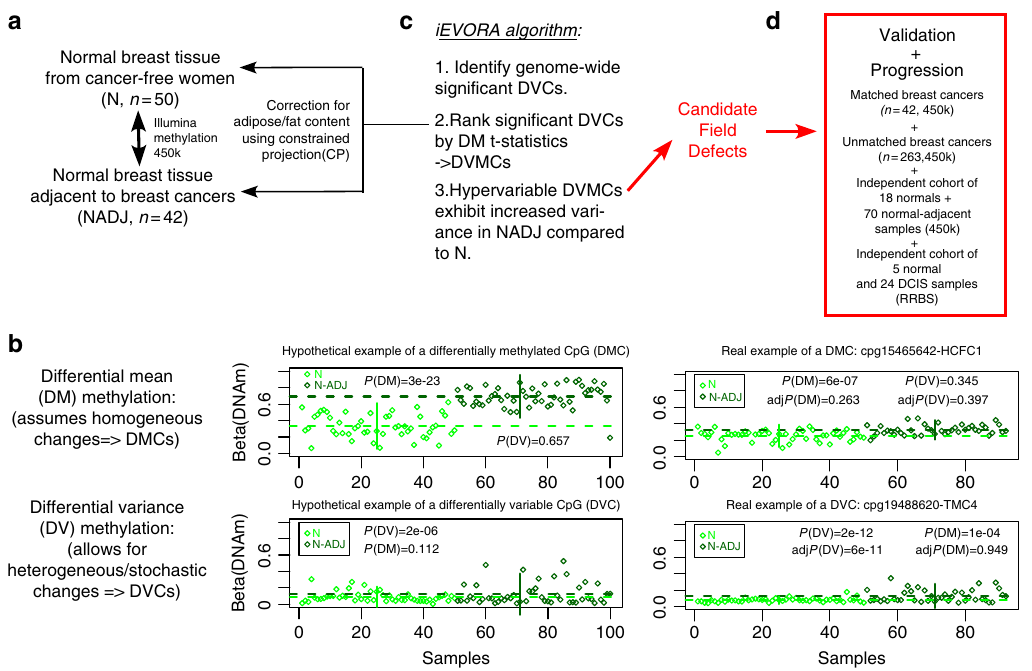
Figure 1 | Overall analytic strategy for identifying and validating field defects in breast cancer. ( a ) Aim is to identify DNA methylation changes between normal tissue from cancer-free women (N) and age-matched normal samples adjacent to breast cancers (NADJ). This is done correcting for variable adipose/ fat content across breast tissue samples and then performing a supervised analysis. ( b ) Two feature selection paradigms are possible: (i) a standard paradigm by which we select differentially methylated CpGs (DMCs) and which assumes homogeneity within the phenotypes being compared, (ii) a novel paradigm, based on the notion of differential variability (DV), which allows for heterogeneous/stochastic changes, and which identifies differentially variable CpGs (DVCs). Profiles to the left depict theoretical examples of a DMC and DVC. P -values are from a t -test for the case of assessing differential methylation (DM), and from a Bartlett’s test for the case of assessing DV. Horizontal dashed lines indicate the mean DNA methylation value, vertical lines indicate the variance ( ± 1.96 standard deviation). To the right, we depict real examples of a top ranked DMC and DVC derived from comparing N to NADJ samples. We give the P - values ( P ) and adjusted P -values (adj P : adjusted for multiple testing) for the case of t -tests (DM) and Bartlett’s test (DV). Horizontal dashed lines indicate the mean DNA methylation value, vertical lines indicate the variance ( ± 1.96 s.d.). Note that for the DVC, the main distinguishing feature is the variance, not the mean. ( c ) The iEVORA algorithm posits that relevant field defects are identified by first using a test for DV to select significant DVCs, and then ranking significant DVCs by a DM t -statistic. This results in differentially variable and differentially methylated CpGs (DVMCs). Those exhibiting increased variance in the NADJ samples represent candidate field defects. ( d ) Validation of field defects using matched and unmatched breast cancer samples, to assess if field defects progress or become enriched in the invasive cancer state, as well as validation of field defects in independent